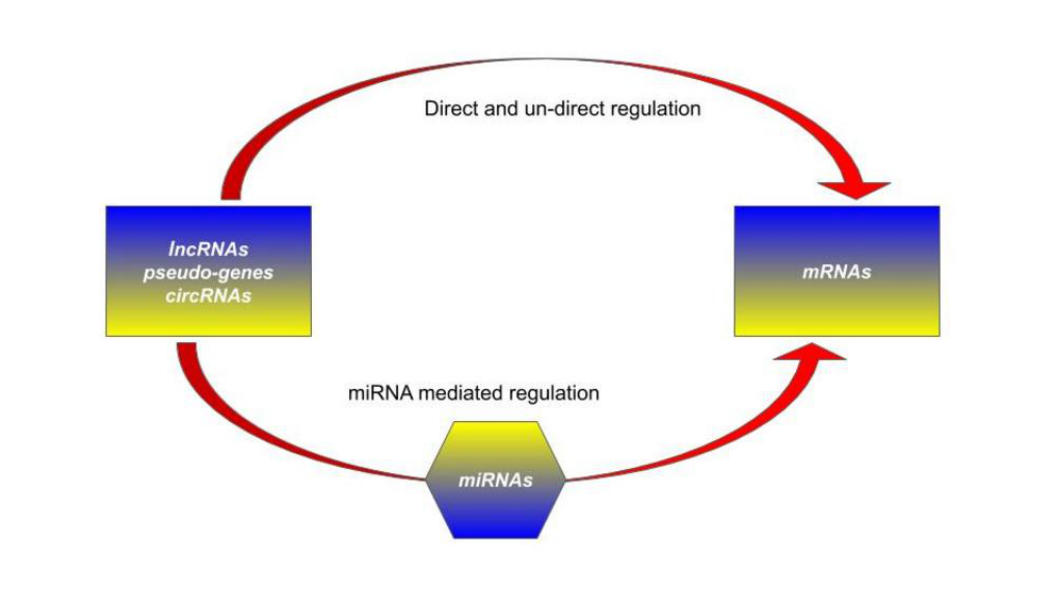
Figure 1. Transcription and post-transcription regulation of messenger RNAs (mRNAs) can be affected by several direct and indirect mechanisms involving circular RNAs (circRNAs), pseudo-genes ( Ψ -genes) and long non-coding RNAs (lncRNAs). Some of these processes act on the transcription rate in the nucleus through the specific RNA–RNA complex, some others help the stability of mRNA molecules in the cytoplasm. Alongside this, the competing endogenous RNA (ceRNA) mechanism offers a parallel and complementary way through the same actors, protein coding and non-coding RNAs, but instead mediated by microRNAs (miRNAs).